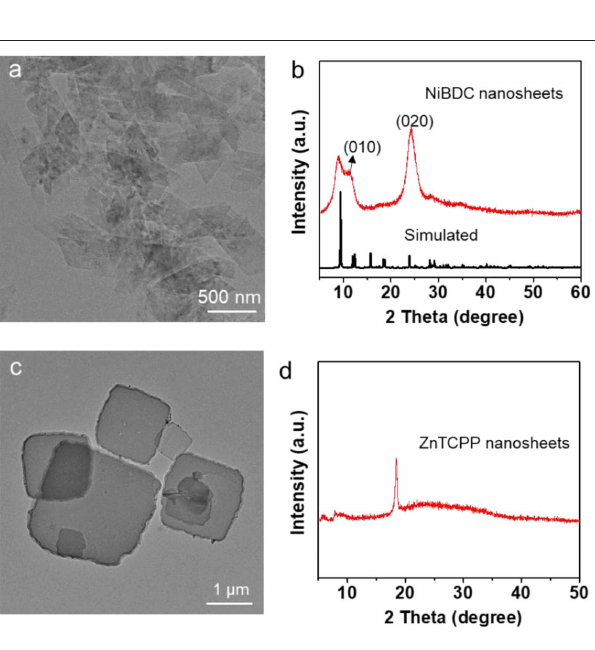
3.1 nm ( Supplementary Figure 6 ). The XRD pattern shows the CoNDC nanosheets have the same crystal structure with the bulk CoNDC crystals ( Figure 3c , Supplementary Figure 7a